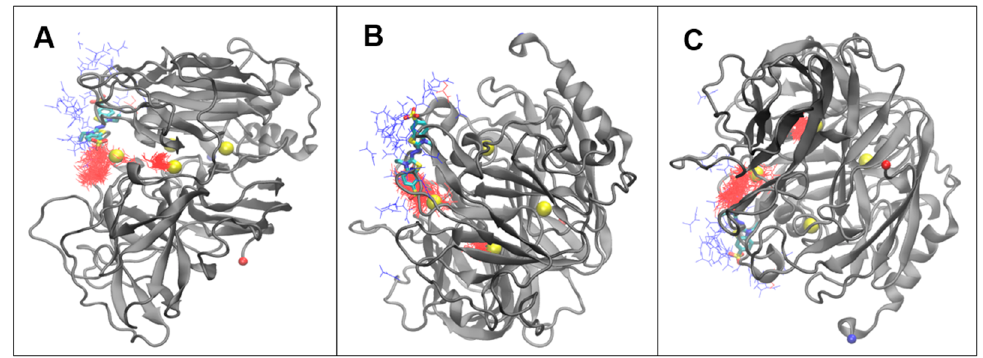
Figure 9. TMG cations and Ser anions within 2 Å of Cu 2+ ions and ABTS (VDW) from the trajectories. ( A ) Side view, ( B ) Top view; ( C ): Bottom view; Laccase protein: grey ribbons; Cu 2+ ion: yellow ball; SER anion: red line; TMG cation: blue line; N-terminus: red ball; C-terminus: blue ball.